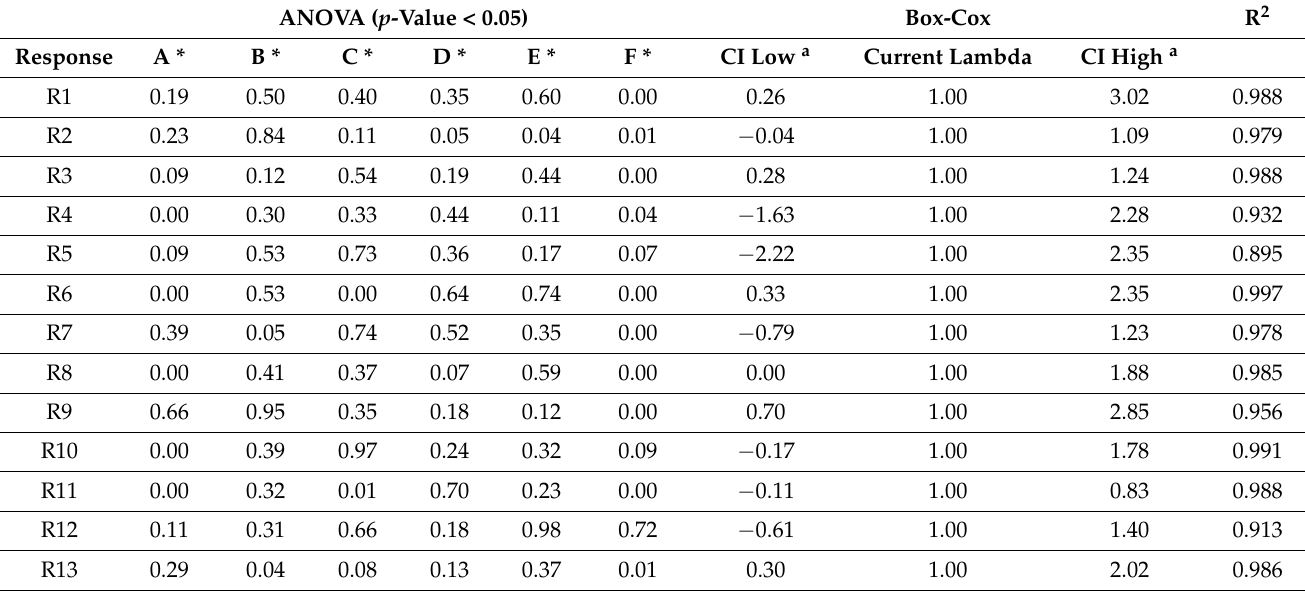
Table 4. ANOVA, Box-Cox and determination of coefficient (R 2 ) of each response subjected to the model. ANOVA ( p -Value < 0.05) Box-Cox R 2